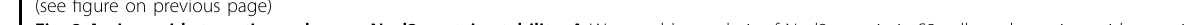
Fig. 2 Amino acid starvation enhances Nprl3 protein stability. A Western blot analysis of Nprl3 protein in S2 cells under amino acid starvation. B qRT-PCR analysis of nprl3 mRNA in S2 cells under amino acid starvation. Error bars represent standard error values from three independent experiments. C Western blot analysis of the Nprl3 protein in S2 cells treated with actinomycin D together with amino acid starvation. D Ovaries from yw fl ies were dissected and cultured in amino-acid-free Schneider ’ s medium (AA-) for 2 h. Nprl3 was detected using Western blot. E S2 cells were transfected with the pAC5.1 construct inserted with nprl3 5 ’ UTR, V5-tagged Nprl3 coding region, and nprl3 3 ′ UTR. The cells were starved for the indicated time and the V5-Nprl3 levels were measured by western blot. F S2 cells were transfected with the pAC5.1 construct inserted with V5-tagged Nprl3 coding region. The cells were starved for the indicated time and the V5-Nprl3 levels were measured by western blot. G S2 cells were transfected with the pAC5.1 construct inserted with V5-tagged Nprl3 coding region. The cells were treated with CHX alone or CHX together with amino acid starvation medium for the indicated time. The V5-Nprl3 levels were measured by western blot. The remaining protein levels at each time point were calculated, taken the expression level of V5-Nprl3 at 0 h as 1. Error bars represent standard error values from three independent experiments. ** P < 0.01; *** P < 0.001. H S2 cells were transfected with the pAC5.1 construct inserted with V5-tagged Nprl3 coding region. The cells were treated with CHX alone or CHX together with MG132 for the indicated time. The V5-Nprl3 levels were measured by western blot. I Western blot analysis of endogenous Nprl3 protein in S2 cells under amino acid starvation and MG132 treatment. Rp49 was used for normalization for qPCR. α - Tubulin was used as a loading control for western blot. Similar western blot results were observed in more than three independent experiments for each